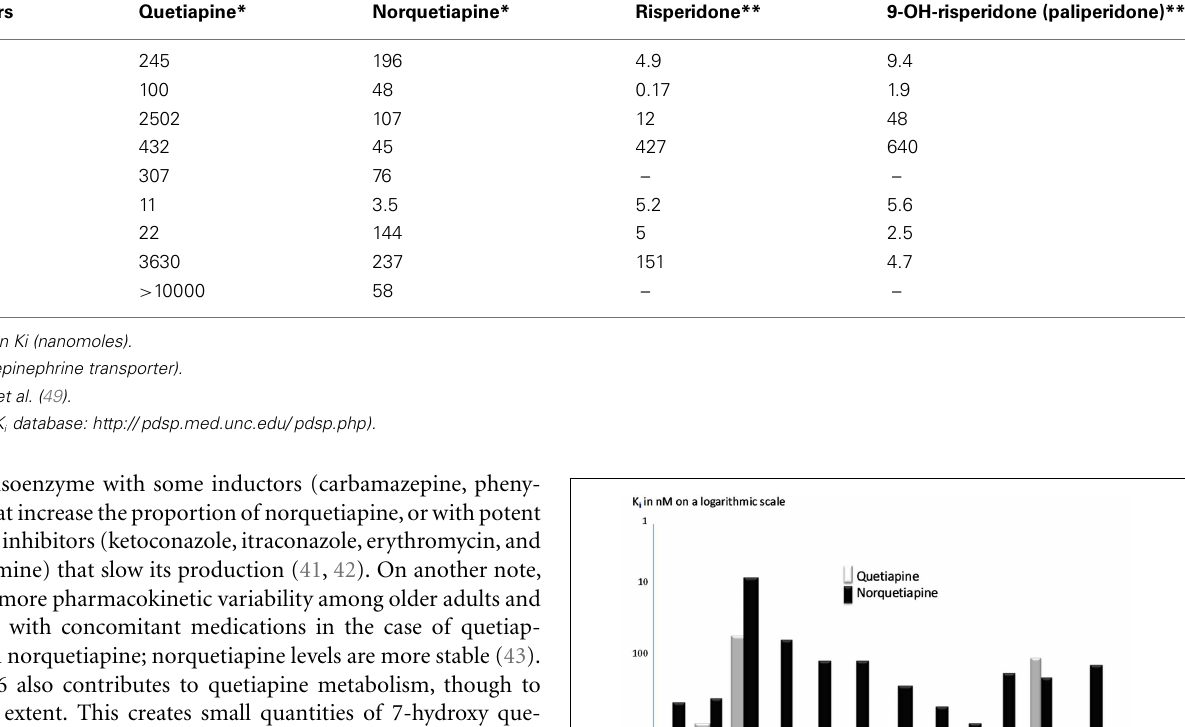
Table 2 | Pharmacodynamic properties of quetiapina, risperidone, and their active metabolites (norquetiapine and paliperidone). Receptors